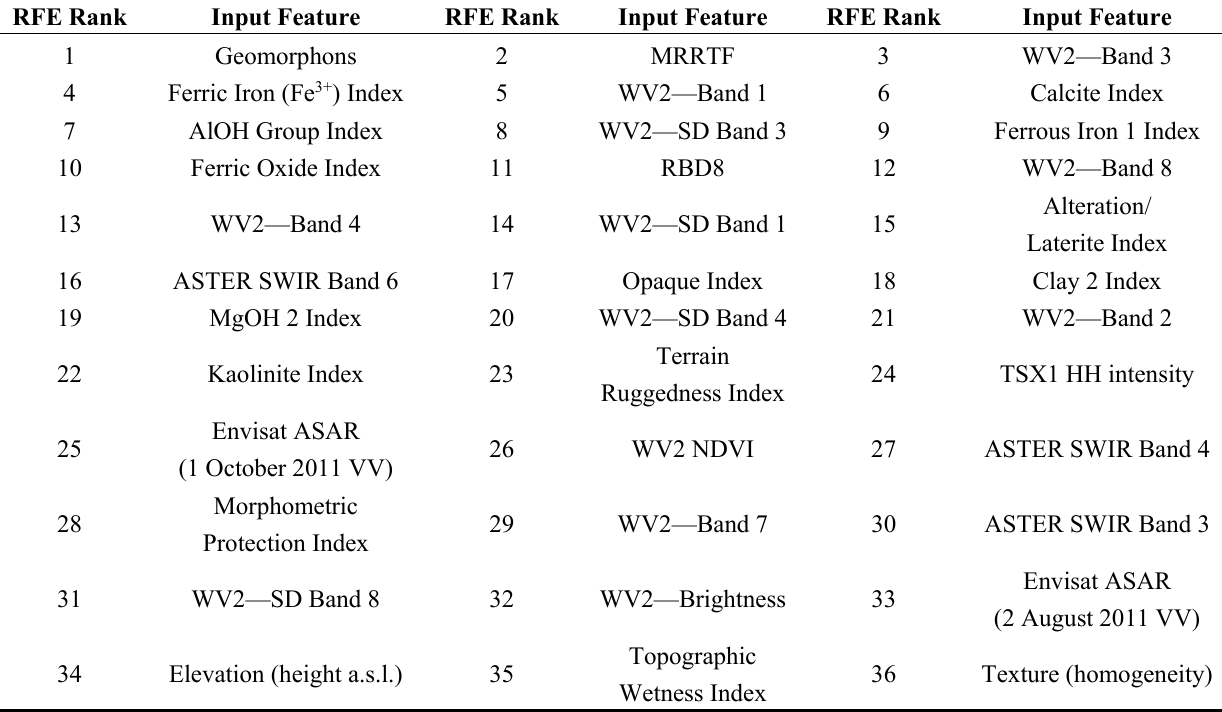
Table 7. Relevance ranking of RFE selected input features. SD, standard